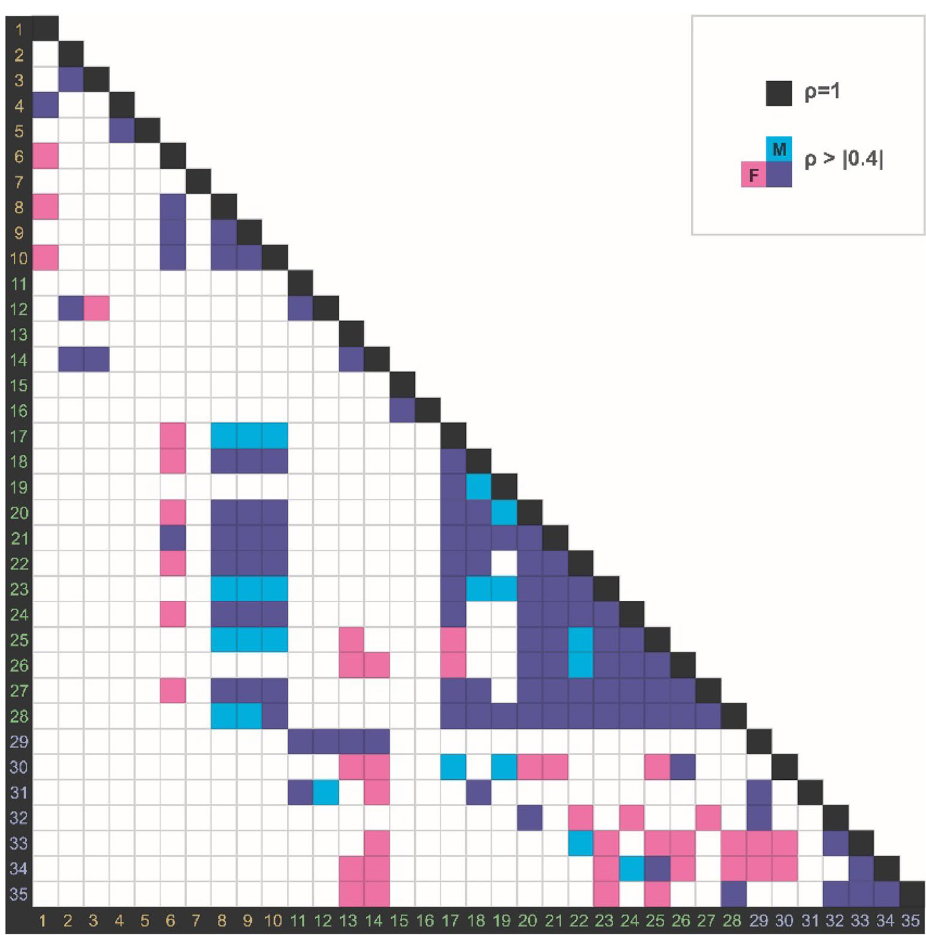
Figure 1. Summarized results of Pearson’s correlation coefficient in male (cyan) and female (magenta) groups. The cells represent correlations between measurement sections. Colored cells indicate correlation showing ρ >|0.4| on both left and right sides ( p < 0.05).